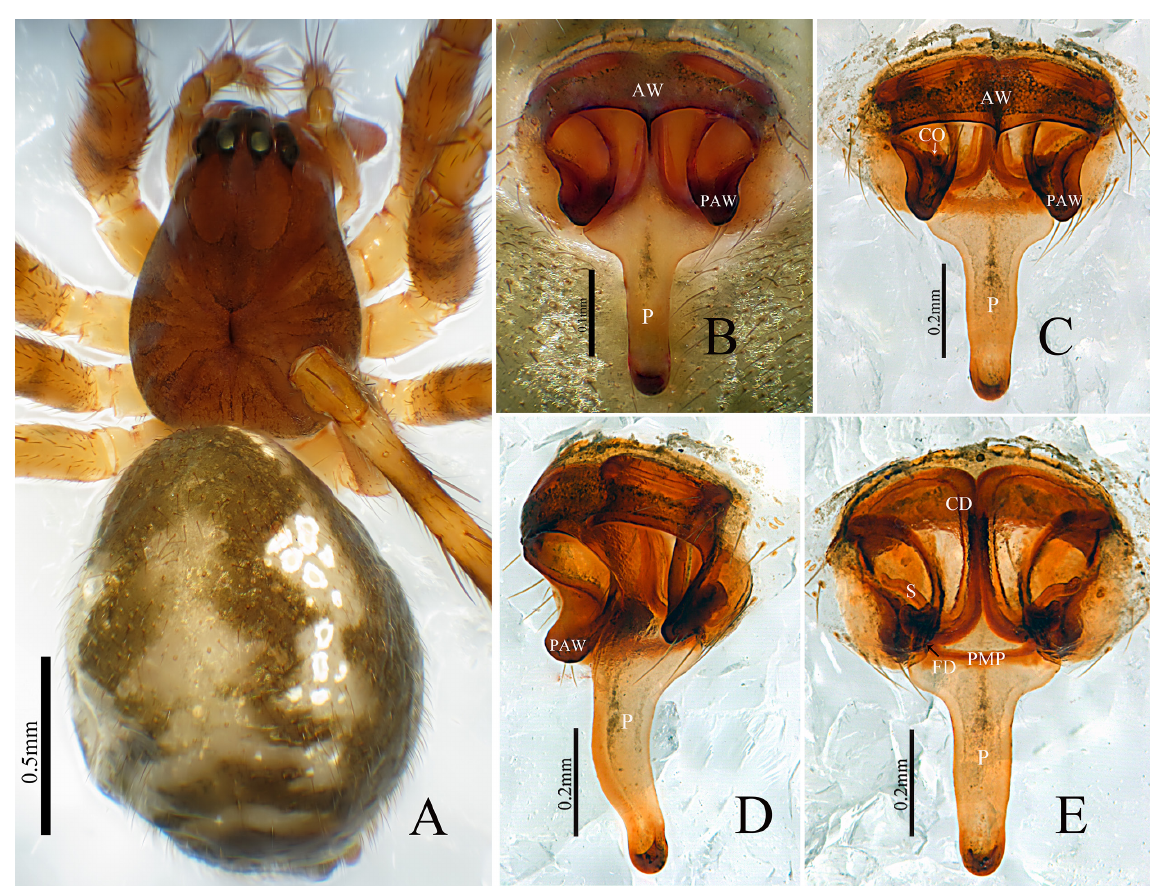
Fig. 34. Acroterius longiprojectus gen. et sp. nov., ♀, holotype (HNU-Tang–05–06). A . Habitus, dorsal view. B–C . Epigyne, ventral view. D . Epigyne, lateral view. E . Vulva, dorsal view